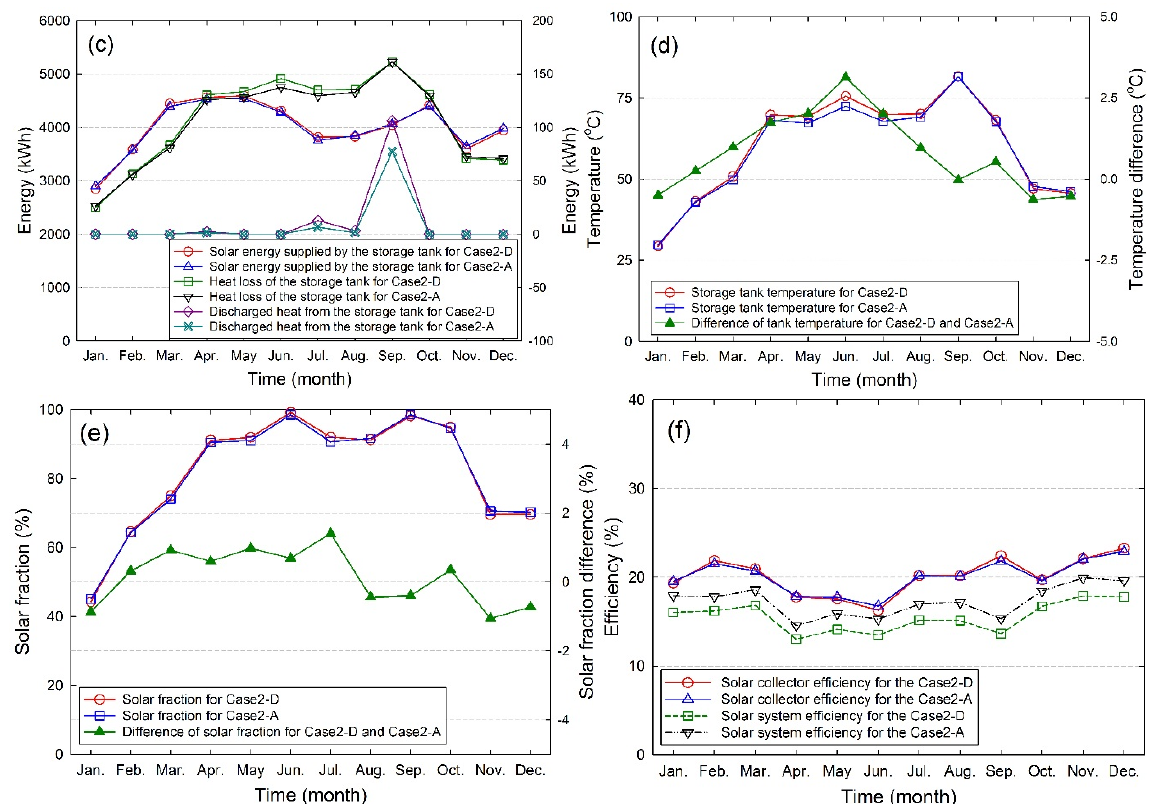
Figure 8. Comparison of the monthly energy performances of the optimal SWH